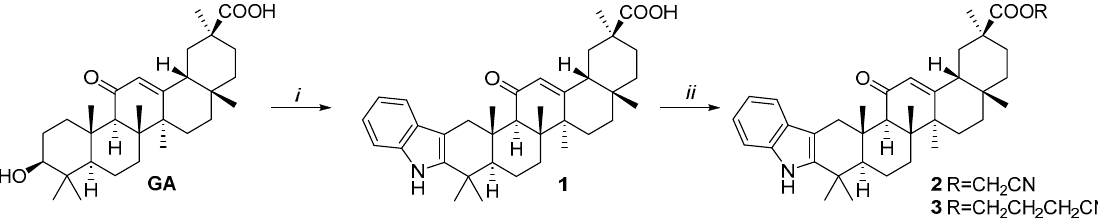
Figure 1. Heterocyclic derivatives of GA with biological activity [9,10].